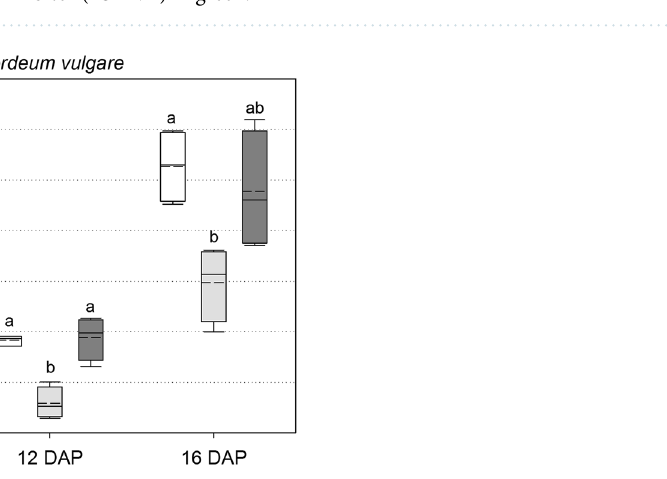
Figure 7. Relative frequencies [% of all soil voxels in the respective layer] of soil-root distances at 16 DAP for representative samples given in Fig. 6, separated in 3 layers, representing the fertiliser layer (middle) and both parts above (left) and below (right) the fertiliser layer. The control treatment (“C”) is given in red, urea (“U”) in blue and urea with nitrification inhibitor (“U+NI”) in green.